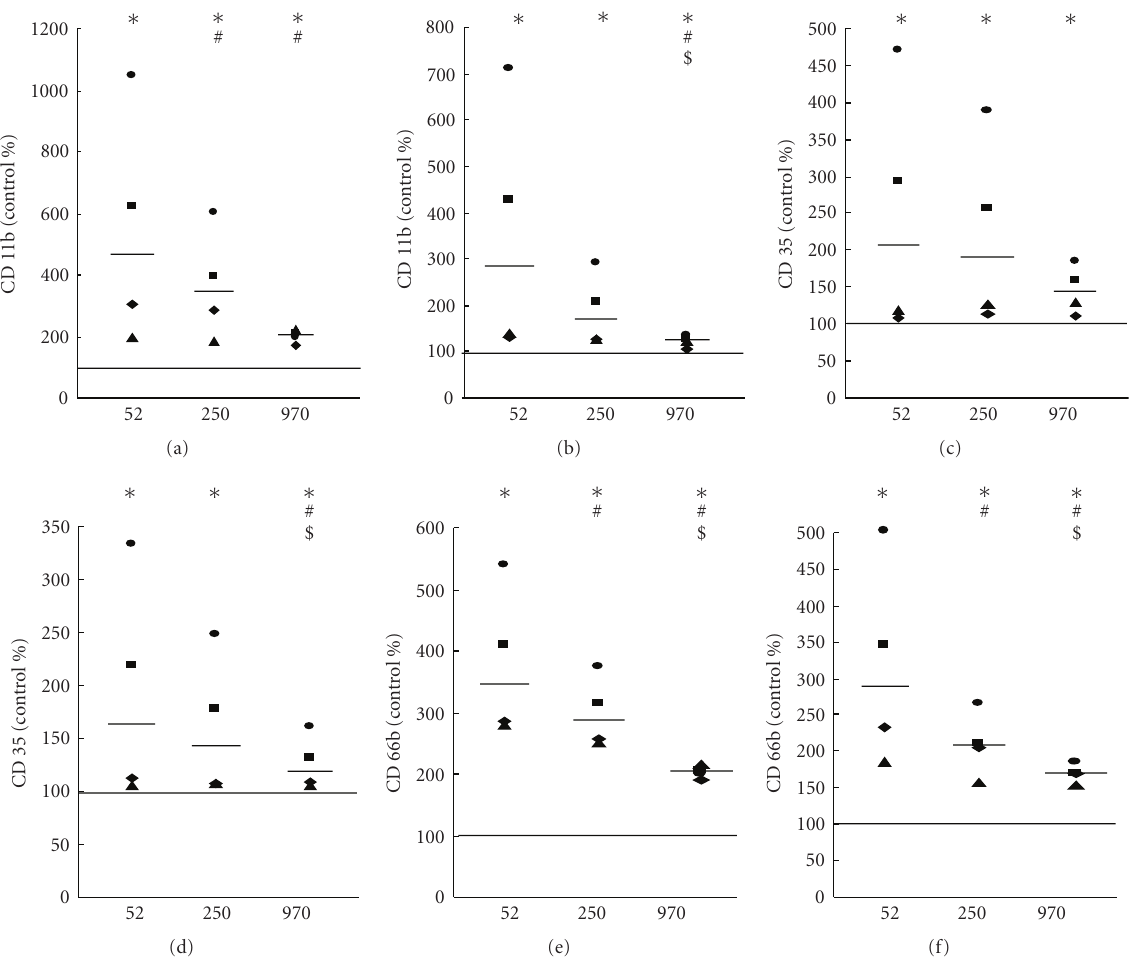
Figure 4: E ff ect of di ff erent MW HA (100 μ g/mL) on the surface expression of CD11b (a, b), CD35 (c, d), and CD66b (e, f), determined after incubation for 30 minutes or 120 minutes after addition of HA in absence (a, c, e) and presence of collagen (0.16mg/mL) (b, d, f). The bold line represents the median, and data points from parallel measurements are presented by the same symbol. Statistically significant di ff erences among di ff erent groups ( P < . 05) are marked by di ff erent symbols: ( ∗ ) statistical significance to control, (#) statistical significance to sample incubated with 52kDa HA, and ($) statistical significance between samples incubated with 250kDa and 970kDa HA.